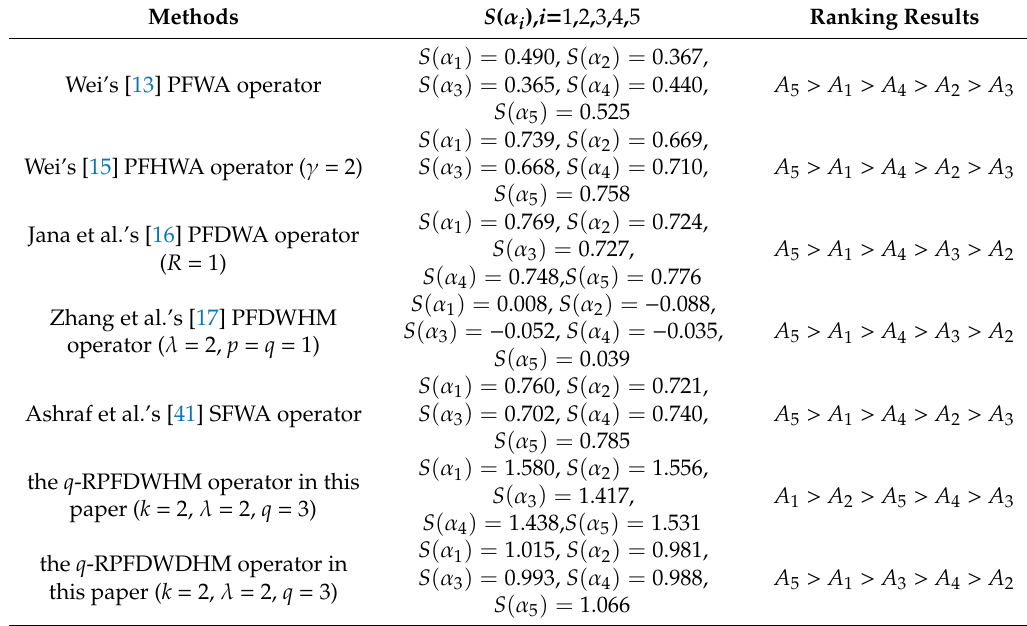
Table 8. Score values and ranking results using our operator and other picture fuzzy